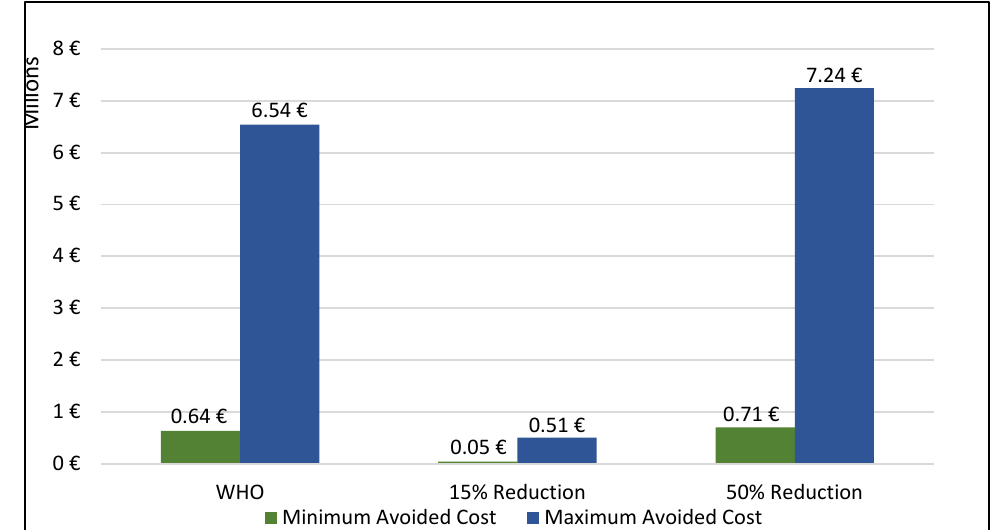
Figure 1. Benefits of PM10 emission reductions. Total avoided hospital cost of the scenarios.